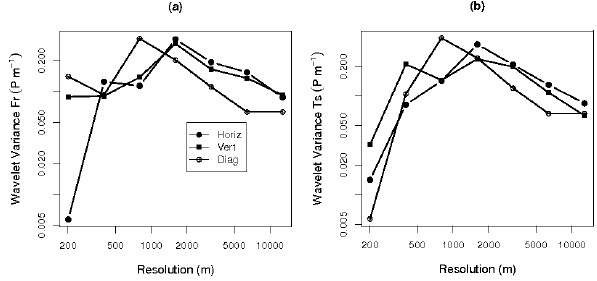
Fig. 2. Two dimensional wavelet spectra [Pm − 1 ] for the (a) frac- tional vegetation and (b) radiometric temperature